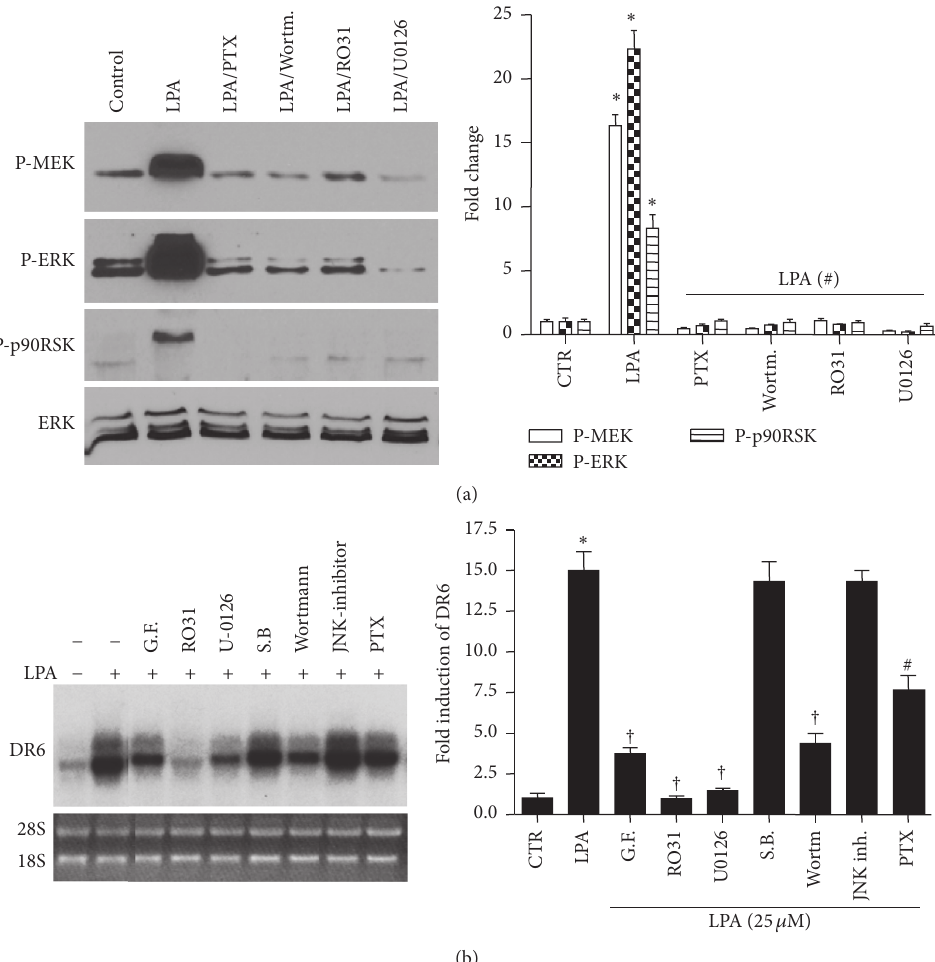
Figure 4: PI3K, PKC, and MEK pathways are involved in LPA-induced DR6 expression. (a) HeLa cells were treated with LPA (25 𝜇 M) in the presence or absence of the pathway inhibitors as indicated. The phosphorylation of MEK, ERK, and p90RSK was analyzed by Western blotting. The blot is a representative of 3 independent experiments. The bar graphs on the right panel are densitometry analyses of MEK, ERK, and p90RSK phosphorylation levels. ∗ 𝑃 < 0.001 versus control; # 𝑃 < 0.001 versus LPA-treated group. (b) HeLa cells were treated with LPA in the presence or absence of the pathway inhibitors as indicated and the expression of DR6 was measured by Northern blot. The bar graphs on the right panel are statistical analysis of DR6 expression. Data presented are mean ± SD from 3 independent experiments, with untreated controls set as 1. ∗ 𝑃 < 0.001 versus control; † 𝑃 < 0.001 versus LPA alone; # 𝑃 < 0.001 versus LPA-treated group. PTX,